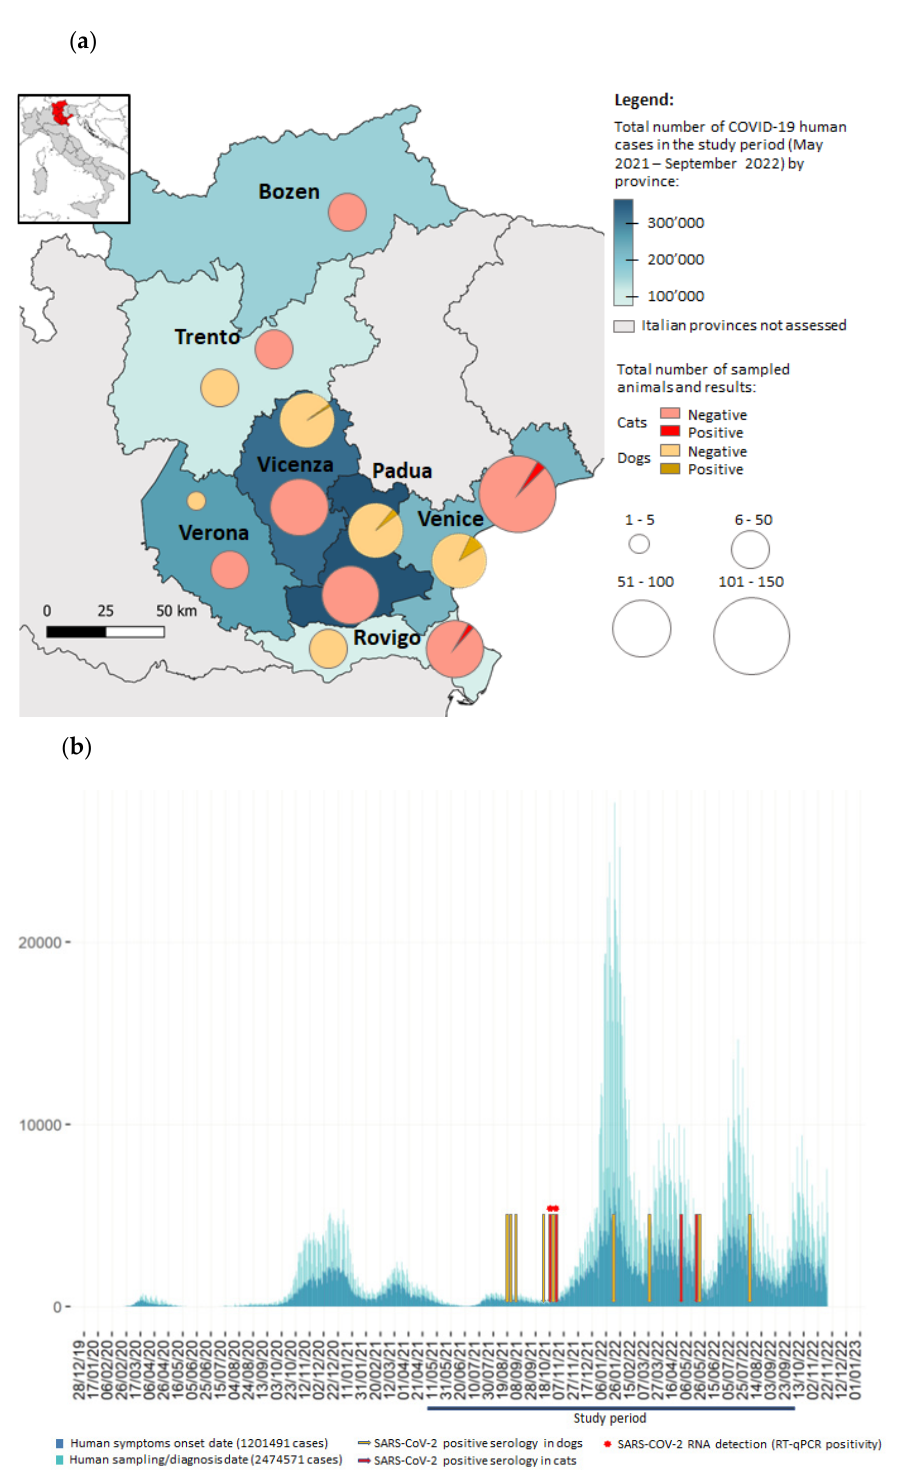
Figure 1. ( a ) Outline of the Italian provinces participating in the study, the color scale identified the total number of human cases reported during the study period from May 2021 to September 2022 (Italian Ministry of Health: https://www.salute.gov.it, accessed on 25/10/2022). Distributions and result of the sampled animals by province are shown. ( b ) Details of the serological and molecular positive sample in dogs and cats, compared to the curve of daily new cases reported in the Veneto region during the study period.